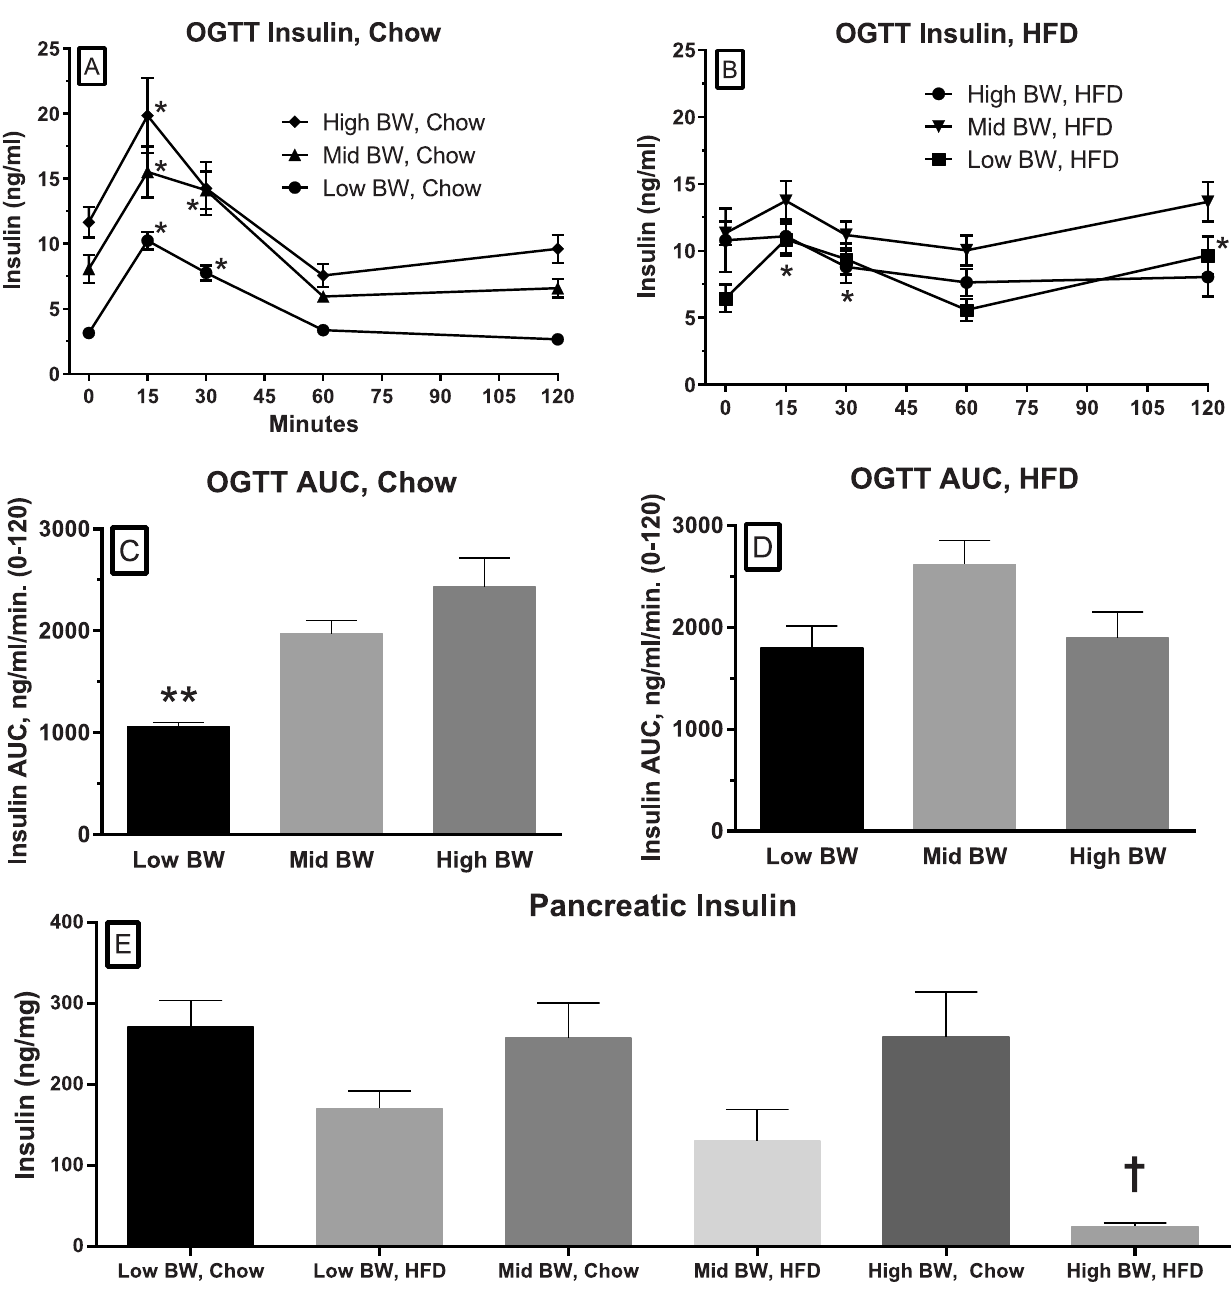
Fig 3. The effects of initial weight and diet on insulin levels during the OGTT. This graph illustrates the insulinresponse to a glucose load at 18 weeks in the Low BW, Mid BW and High BW groups when fed the Chow diet (A) or the HFD (B). The * (A, B) indicatessignificant increasesfrom baselinefor that group (two-way ANOVA followedby Sidak’smultiple comparisontests). The insulinAUCs (C, D) for the above OGTTs (A, B) are also illustrated; the ** indicatesa significantdifference betweenthe Low BW group and the other two groups (one-way ANOVA followedby Sidak’smultiplecomparisontests). The lowest panel (E) illustrates the insulincontent of the pancreasfrom the different weight groups on the two diets at 21 weeks. The effect of diets was tested in respectiveweight pairs (High BW, Mid BW and High